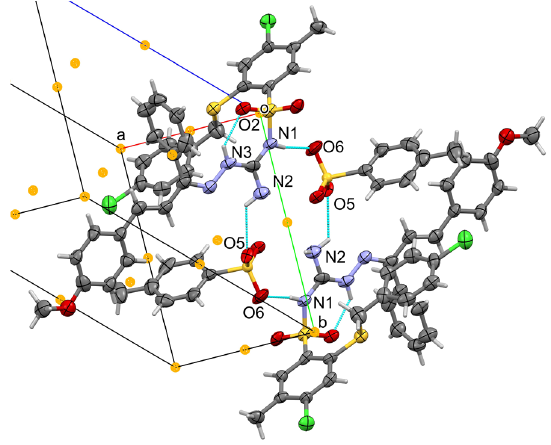
Figure 5. Crystal packing and hydrogen bonding in 31. Four ions are linked by the ring-type hydro- gen bond motif 𝑅 (cid:2872)(cid:2872) (cid:4666)16(cid:4667) NH…N (using N1 and N2 as donors and O5 and O6 from tosyl anion as acceptors) located at the inversion center (drawn as the orange ball). Again, also an internal NH…O cycle S(6) is formed in sulfonamides (compare S.3 Supplementary Material).